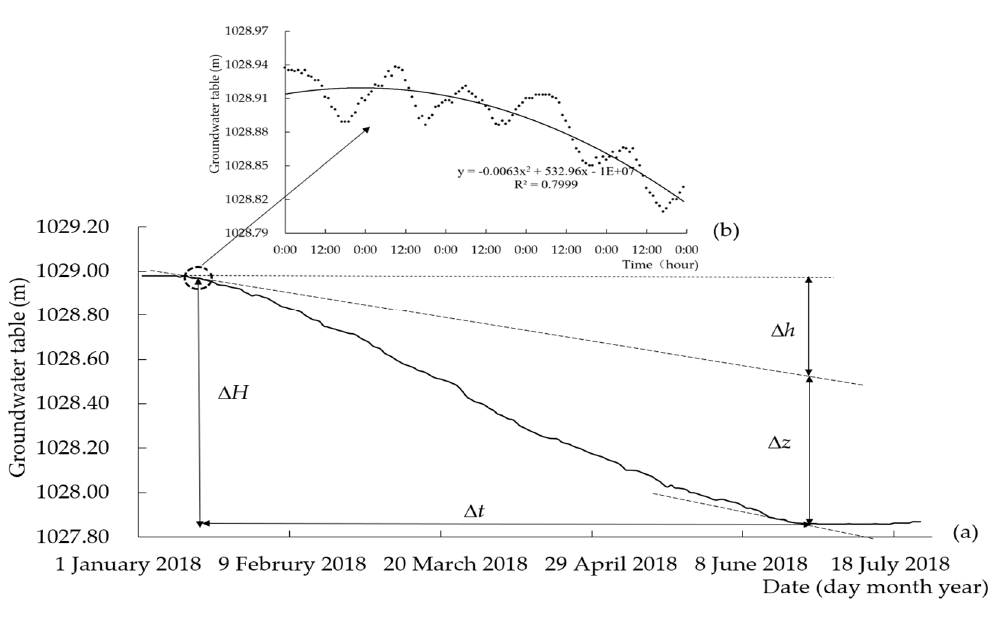
Figure 4. ( a ) Schema of calculating seasonal evapotranspiration from a well hydrograph; ( b ) determined line slope.